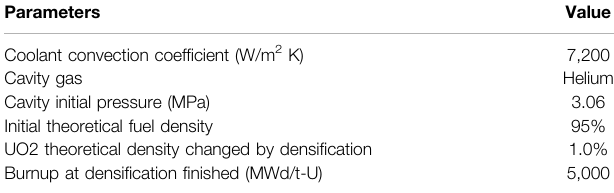
TABLE 2 | Input parameters for